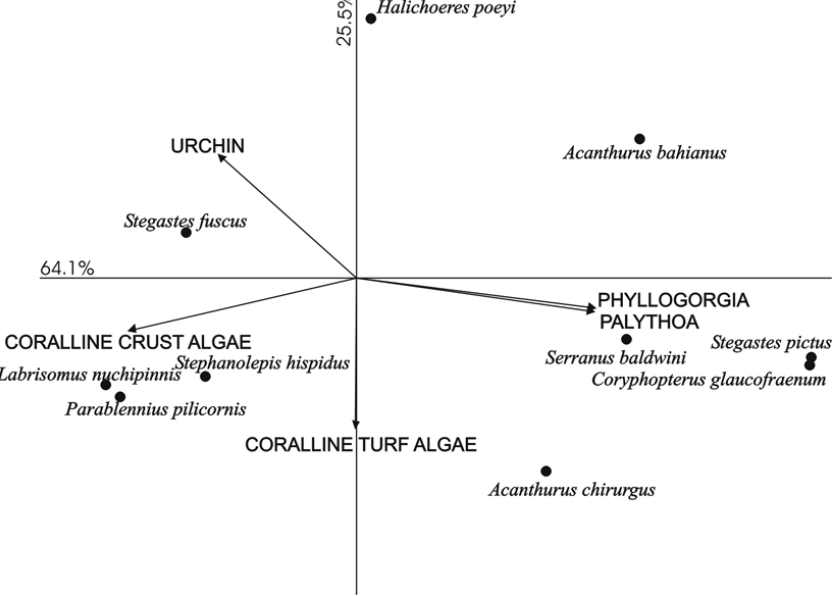
Fig. 6 – Canonical correspondence analysis of fish abundance and benthic organisms obtained from transects on OD patches of Maramutá reefs.